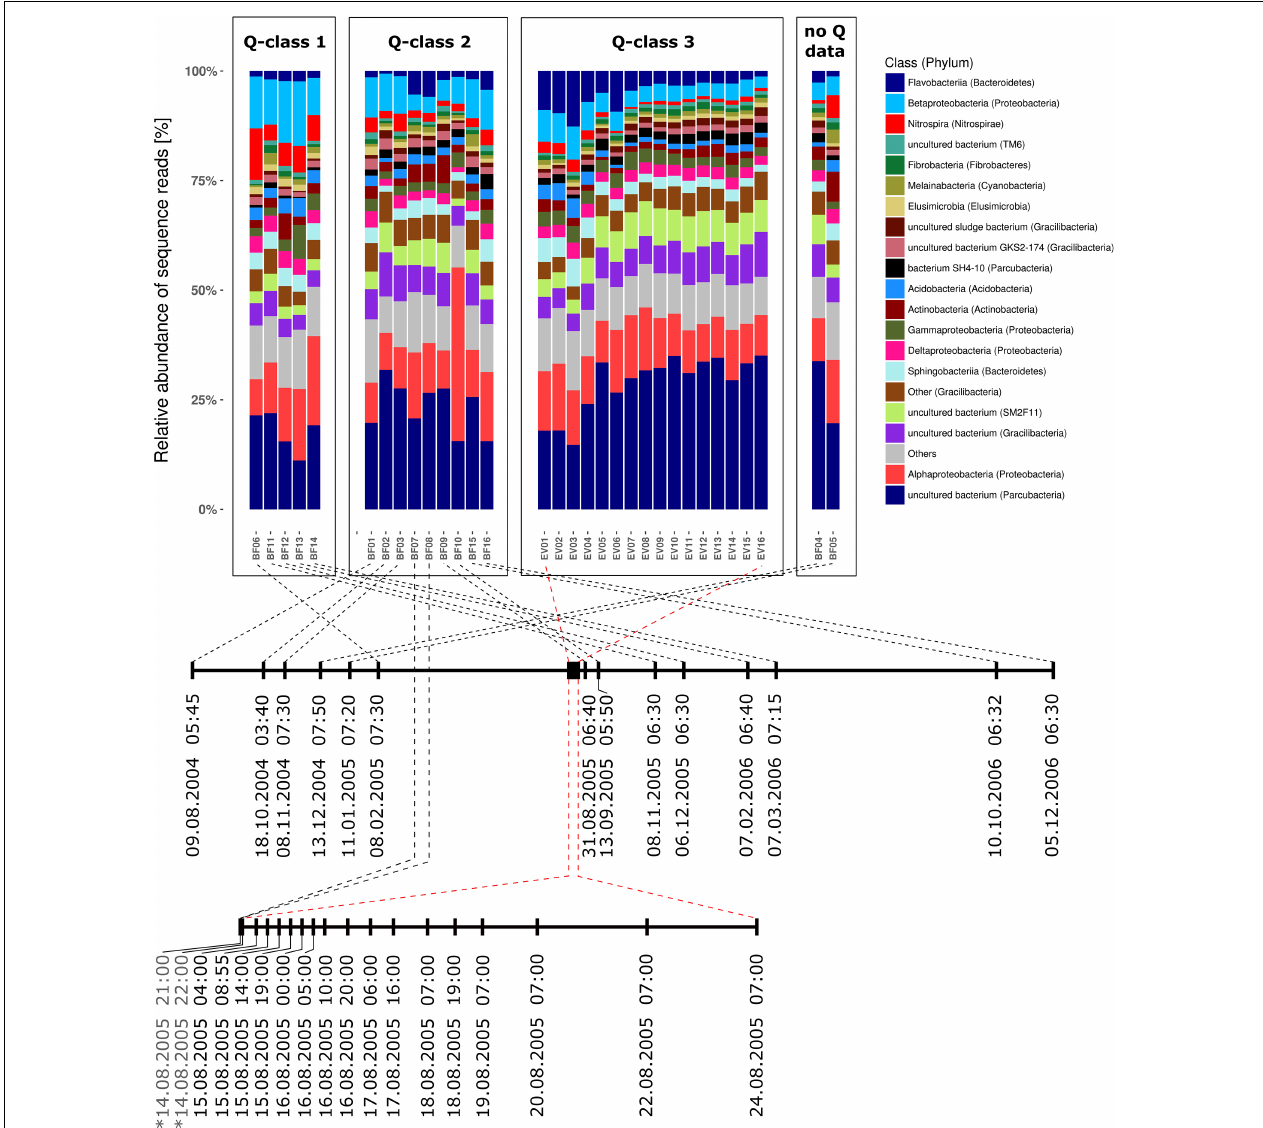
FIGURE 3 | Taxonomic community composition in all investigated samples separated by discharge class (Q1–Q3) and sorted by time of sampling from left to right. Barstacks depict the relative abundance of the 20 most abundant bacterial classes according to SILVA taxonomy (v123; Yilmaz et al., 2014) as well as all additional classes summarized under “ Others .” Brackets contain the respective phylum the bacterial class is affiliated to. Dates signed with a “ ∗ ” in the lower timeline (EV-window) indicate baseflow samples (BF07 and BF08).